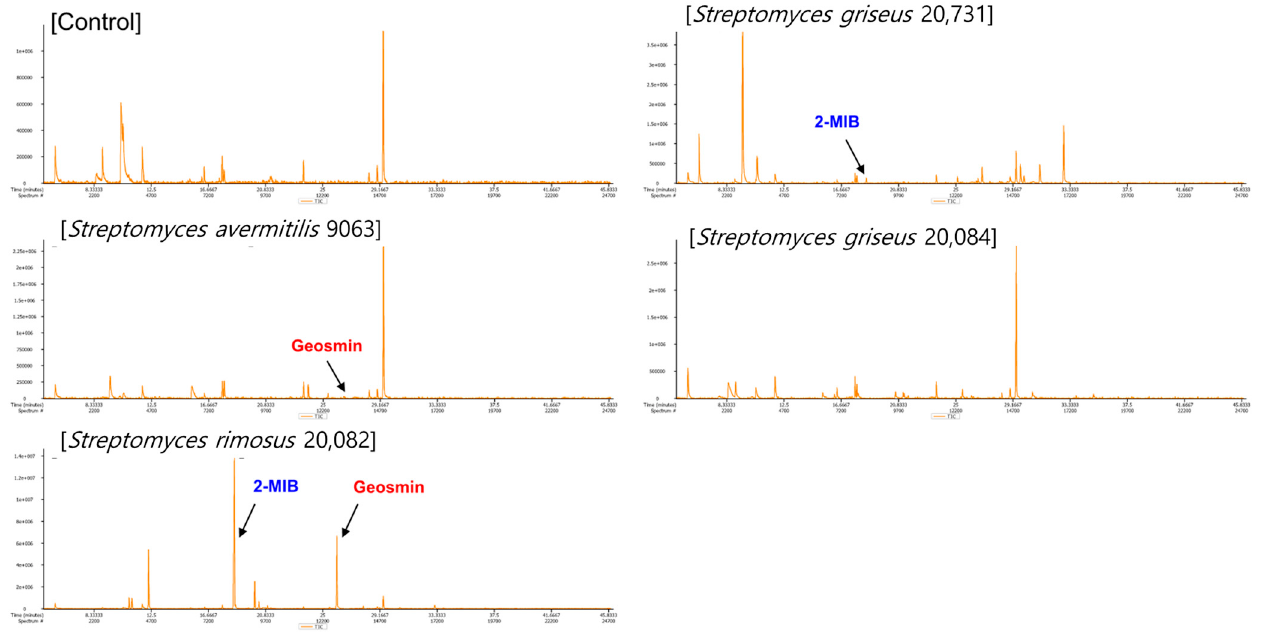
Figure 1. Results of headspace solid-phase microextraction gas chromatography–time-of-flight–mass spectrometry datasets for various Streptomyces strain samples.